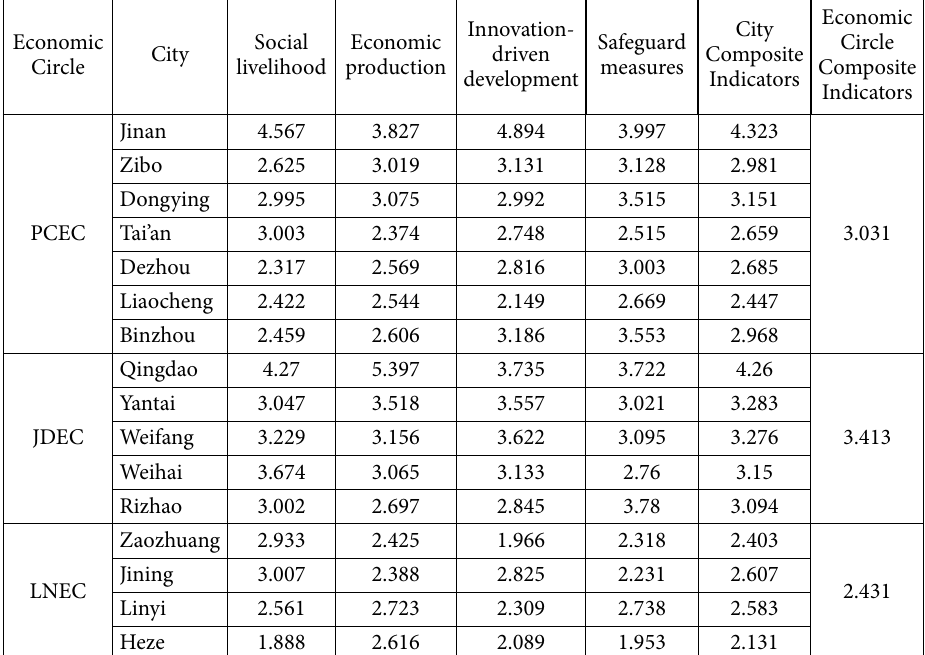
Table 2. Construction level indicators of new SCCs in Shandong Province Economic